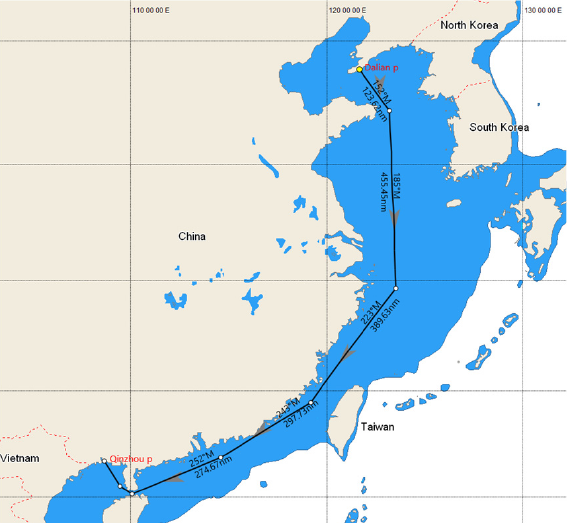
Figure 1. Route of the voyage. Table 1. Route data.